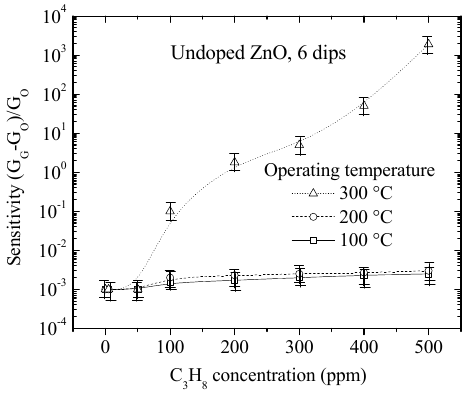
Figure 6. Sensitivity of an undoped ZnO film prepared with six dips as a function of the C 3 H 8 concentration at different operating temperatures.